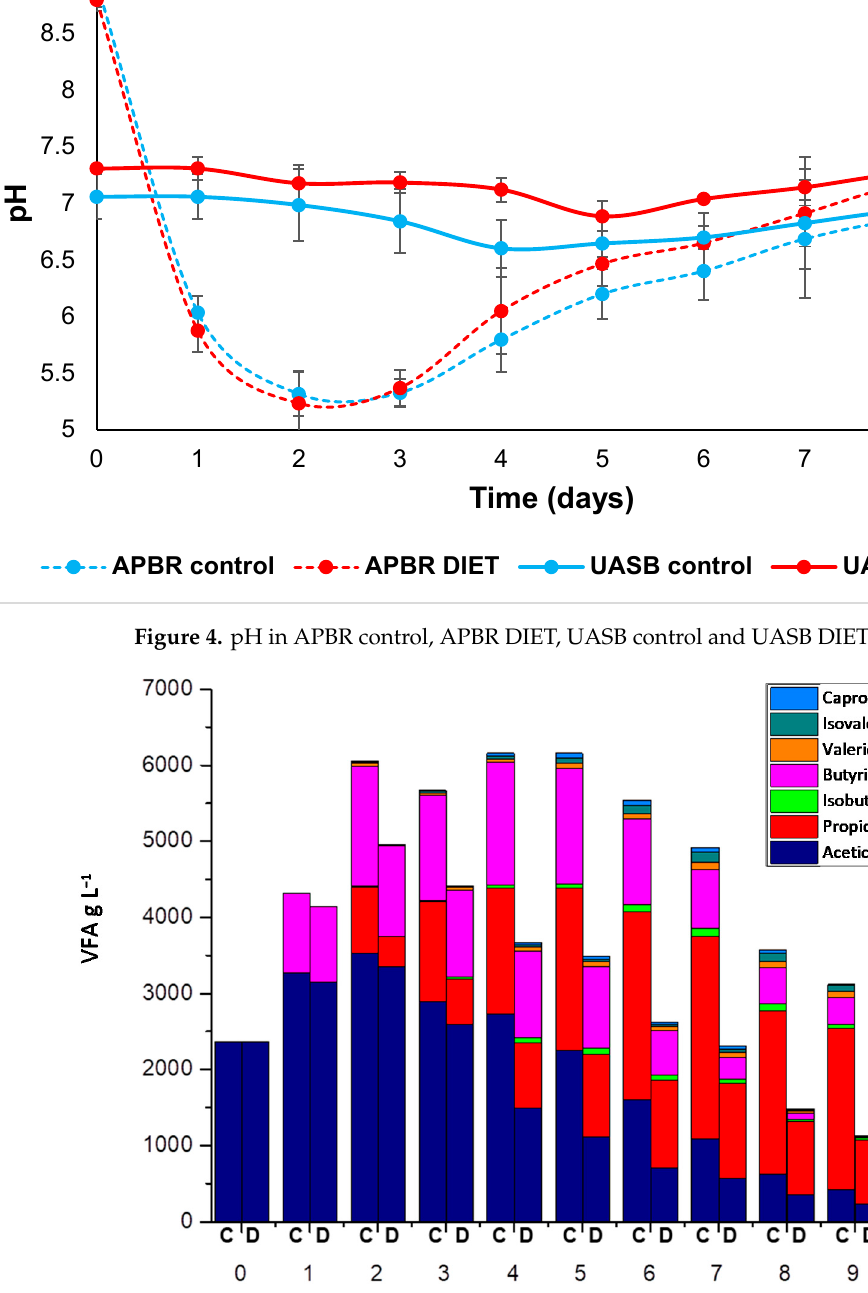
Figure 6. ( a ) COD concentration in APBR control, APBR DIET, UASB control and UASB DIET. ( b ) Methane yield in Control process and DIET process. 3.4.2. APBR DIET + UASB DIET In other studies, it has been shown that pH values are kept more stable in reactors when conductive materials were added, compared to those reactors without [38,39]. In APBR DIET the pH reached a value of 6 on the fourth day and exceeded 7 on the eighth day (Figure 4). Generally, the VFA accumulation causes a pH decrease. In this study, given that these VFA were consumed with greater efficiency through DIET, this pH diminution was avoided in UASB DIET, which kept the reactor in constant conditions. It has been widely reported that DIET process metabolizes alcohols and VFA more efficiently than MIET [40,41]. DIET avoids the inhibition problems of high hydrogen partial pressure and drastic pH drops due to VFA accumulation [18]. When hydrolysis, acidogenesis